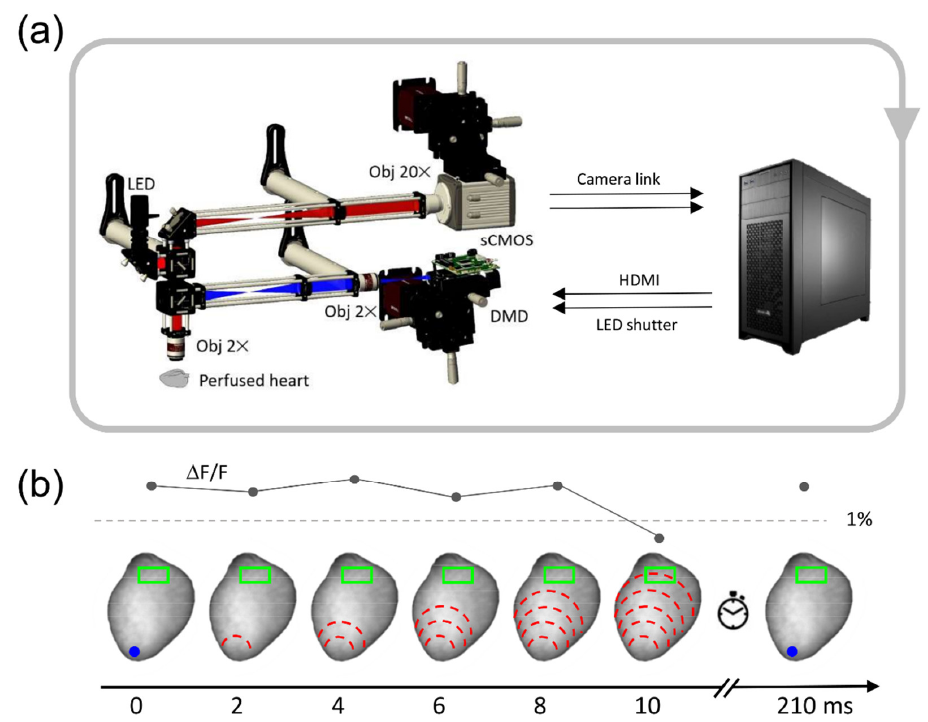
Figure 1. Real-time architecture to mimic ventricular tachycardia. ( a ) Scheme of the wide-field fluorescence mesoscope in tandem with the workstation for real-time analysis and manipulation.